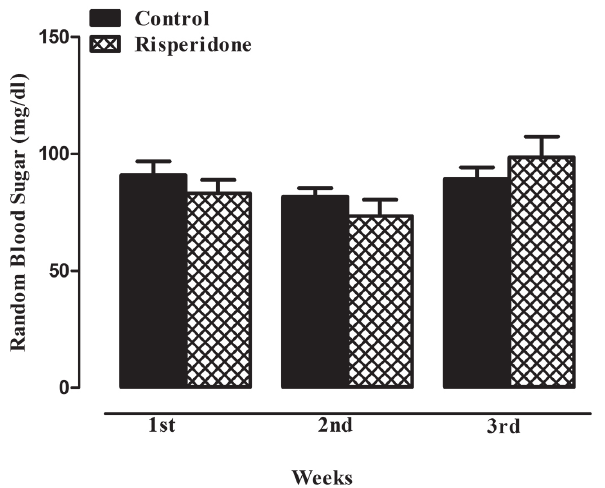
FIGURE 2 - Effect of risperidone on RBS: Three weeks treatment of rats treated with risperidone (2.5 mg/kg/d) orally showing no significant rise in random blood sugar (RBS) (mg/dL) (ANOVA followed by Bonferroni’s Multiple Comparison Test, not significant).